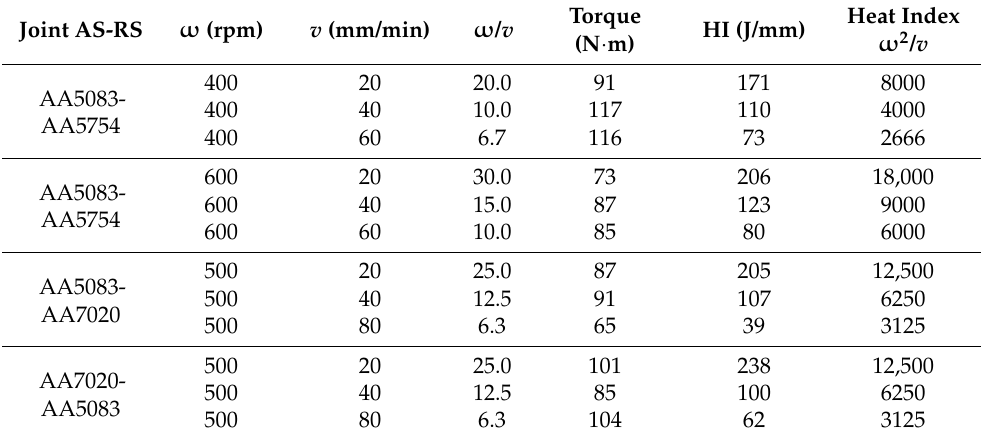
Table 4. Key pseudo-steady-state welding